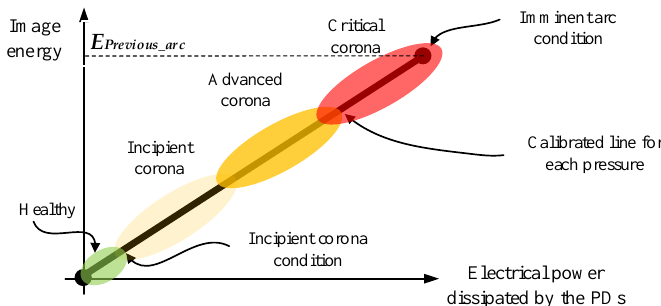
Figure 9. Proposed insulation fault severity chart based on the calibrated line for each particular setup and pressure.